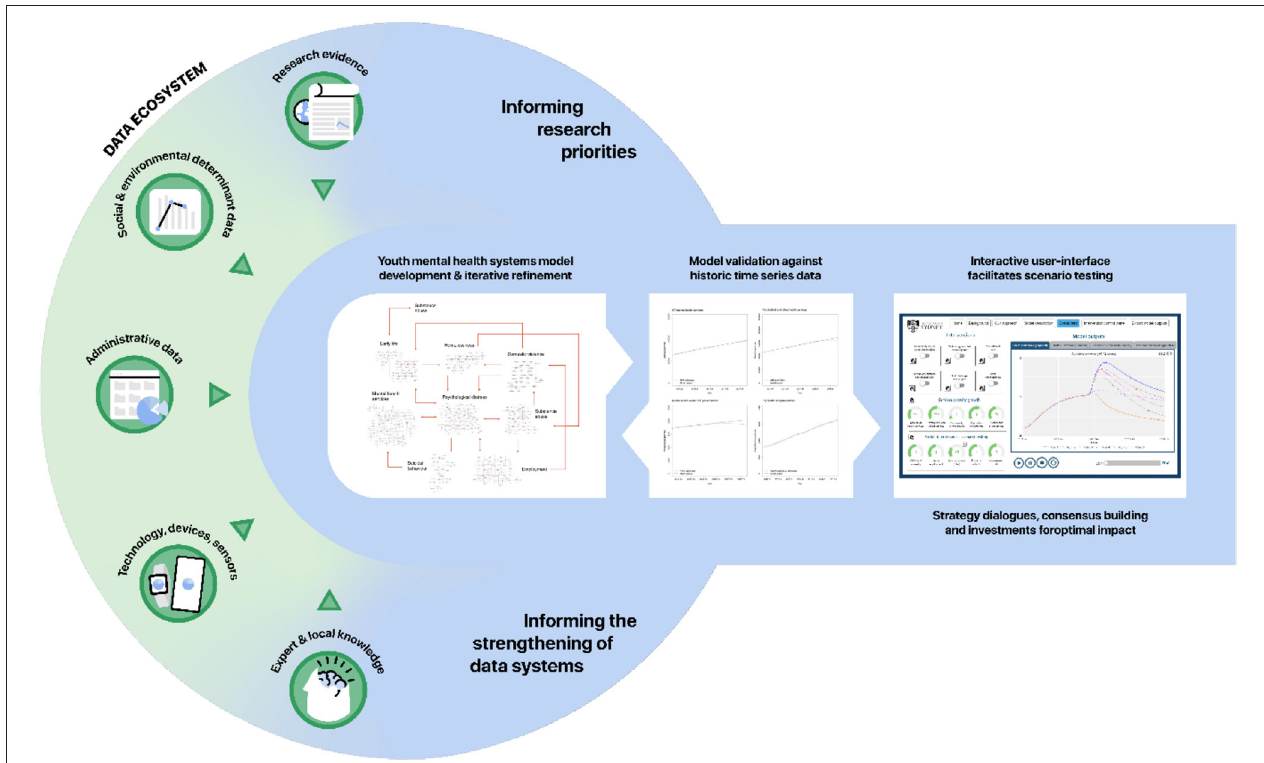
FIGURE 3 | Embedding systems modelling in a continuous system strengthening, monitoring, and evaluation cycle to improve youth mental health.